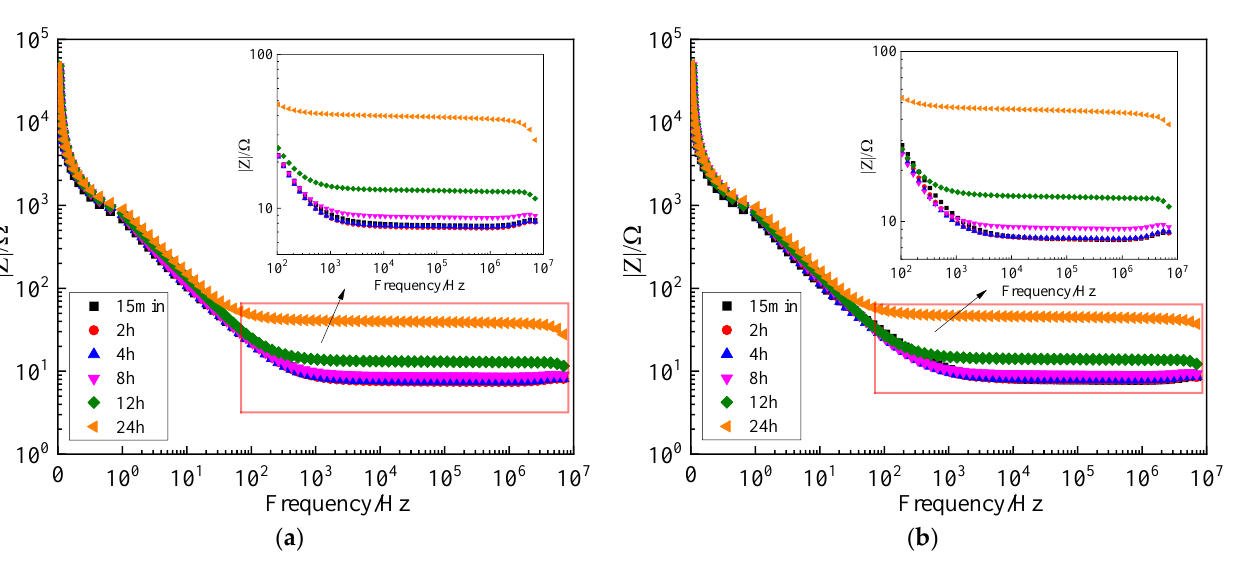
Figure 8. Bode plots with impedance modules of cement paste with superplasticizer addition. ( a ) Cl − NP0; ( b ) Cl − NP1.